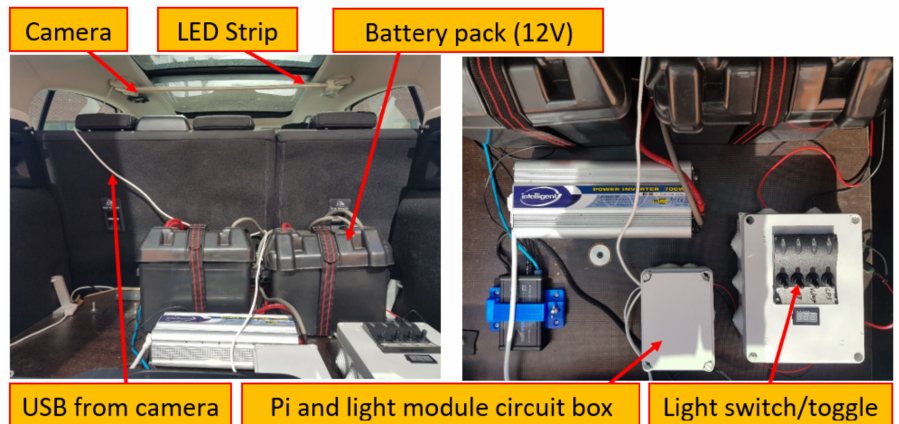
Figure 2. Final configuration within the research vehicle.